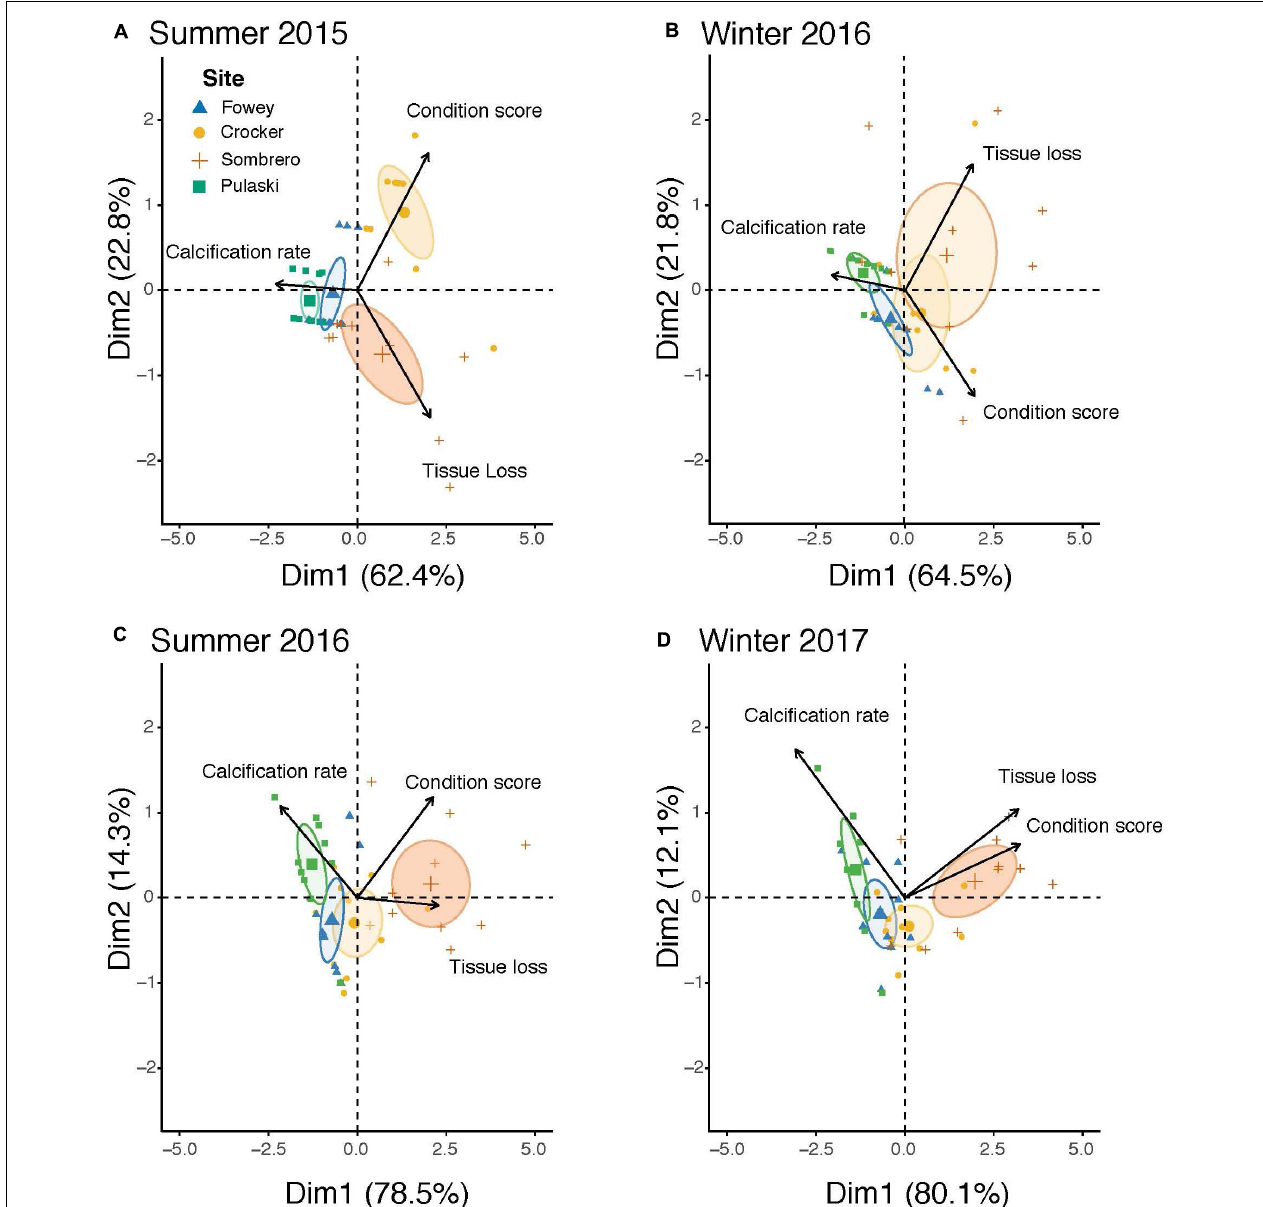
FIGURE 3 | Principal components analysis (PCA) of dimension 1 and 2 with percent variation explained in parentheses consisting of the three traits measured for corals on the Florida Key Reef Tract at each site at each time interval: (A) Summer 2015, (B) Winter 2016, (C) Summer 2016, and (D) Winter 2017. 95% confidence ellipses are placed around the mean of each